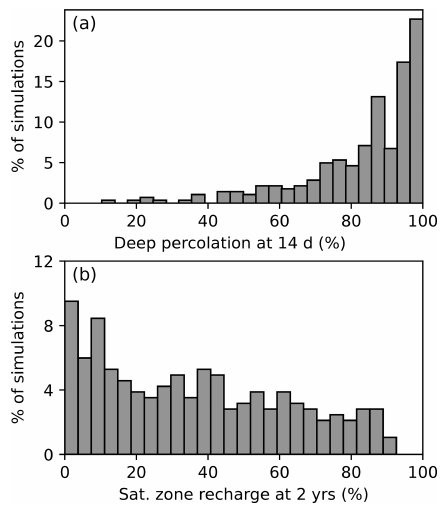
Figure 7. Histogram of deep-percolation efficiency at 14d (a) and saturated-zone recharge efficiency at 2 years (b) for all 284 simula- tions. Deep percolation refers to the proportion of water applied at the surface that has moved beyond the root zone within 14d of the final inundation event. Saturated-zone recharge efficiency ranges from 0.28% to 87.7% (median 32.7%), though the distribution is skewed towards lower